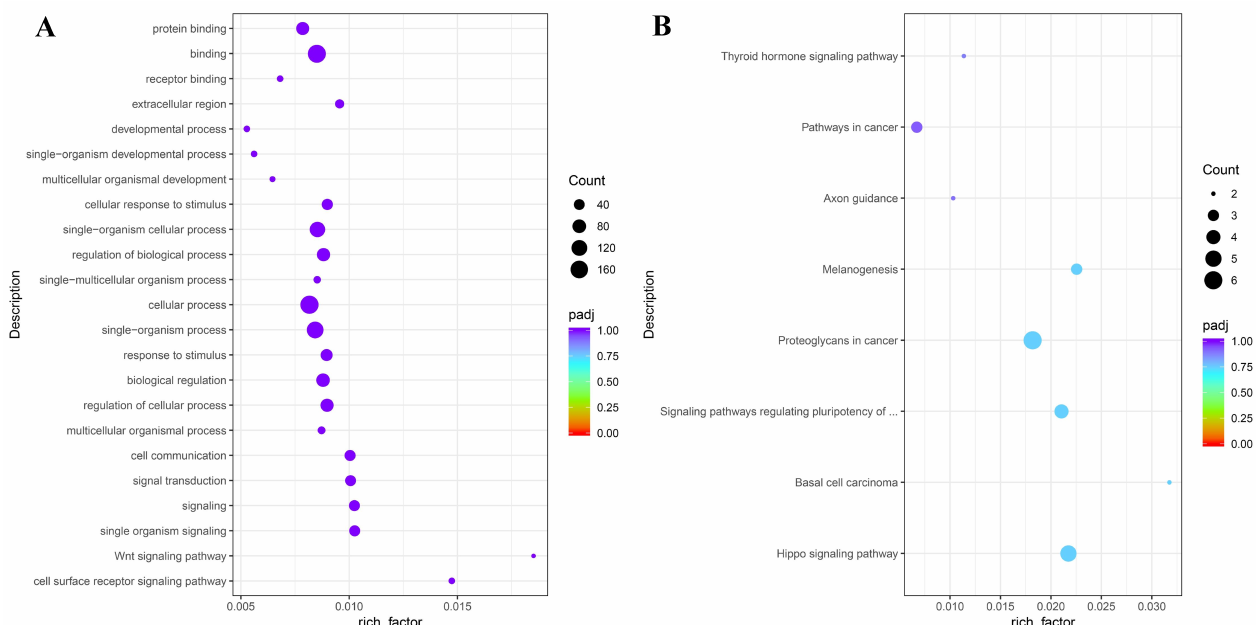
Figure 7. Gene Ontology (GO) and Kyoto Encyclopedia of Genes and Genomes (KEGG) enrichment analyses of PtWnt gene family members between comparisons of regenerating limb bud muscle versus normal limb muscle. ( A ) GO enrichment results; ( B ) statistics of KEGG pathway